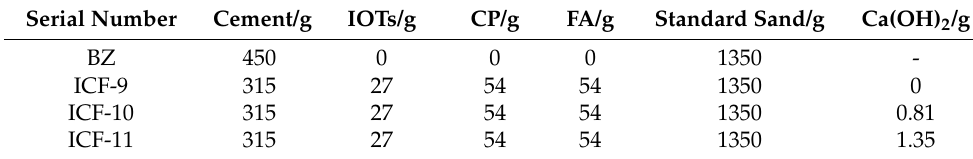
Table 5. Cement mortar ratio of group